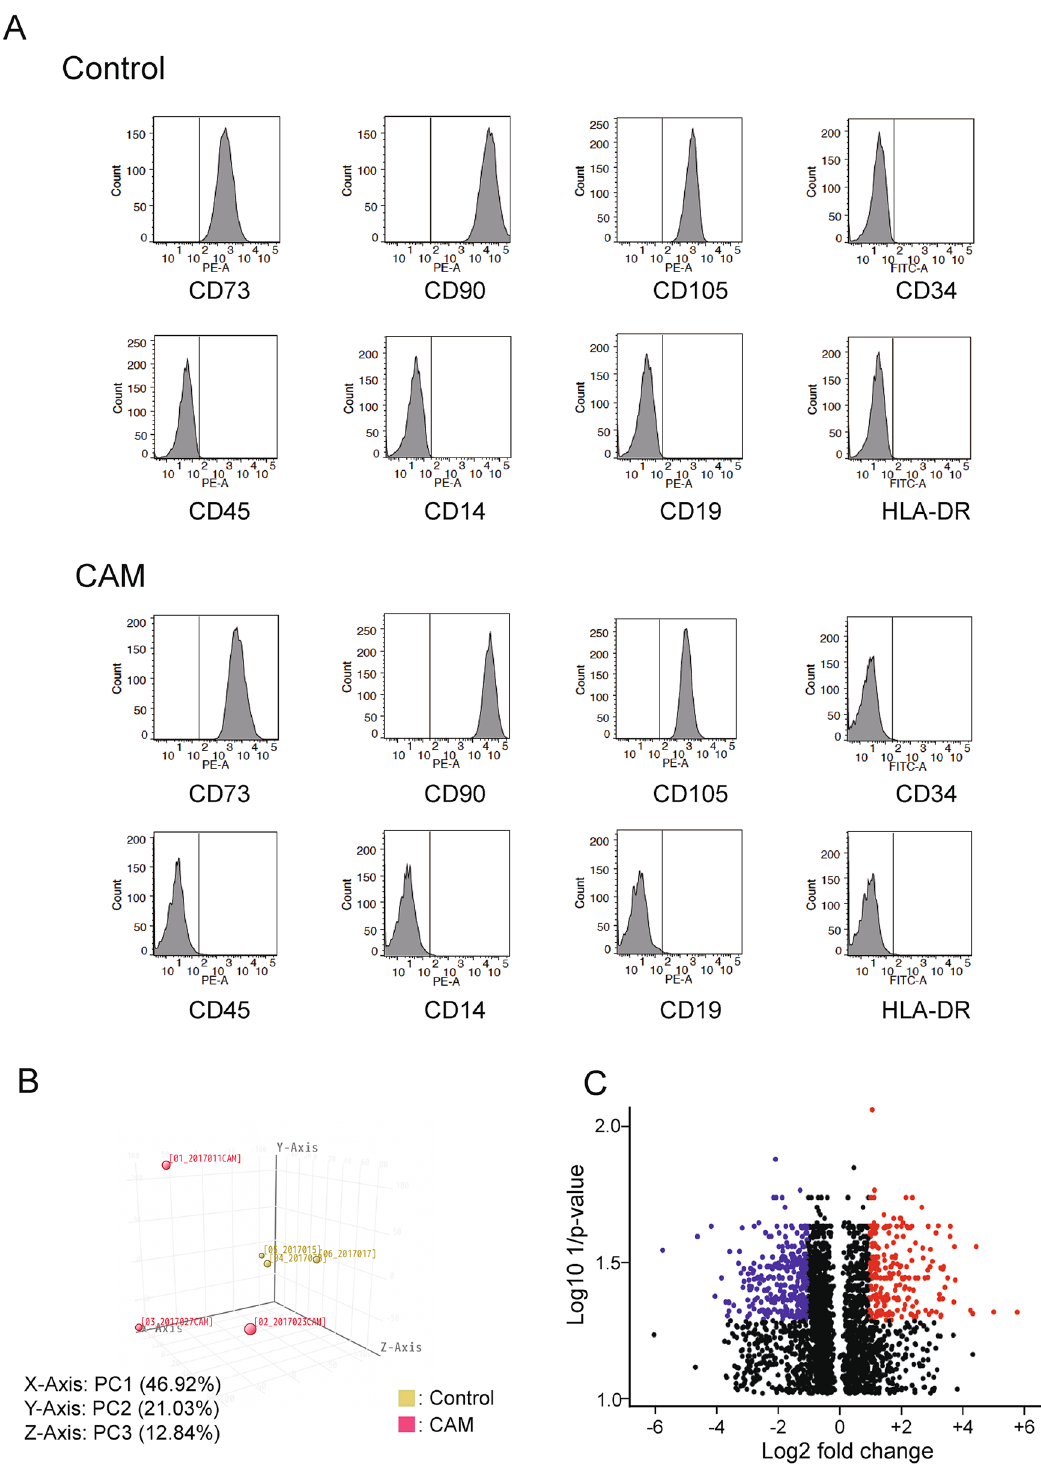
Figure 1. ( A ): Surface marker analysis by flow cytometry revealed that the cells obtained from umbilical cords had UCMSC features. The cells expressed CD73, CD90, and CD105, while not CD34, CD45, CD14, CD19, and HLA-DR; ( B ): Principal component analysis revealed that the gene expression profiles of the CAM group (red) were distinctively different from the normal healthy control, non-CAM group (yellow). ( C ): Volcano plot displaying the results of RNA-seq results from the CAM group and normal healthy controls. The genes that passed the thresholds for p value (Log10 1/ p value > 1.30) and log fold change (Log2 fold change > + 1 or < −1) were colored (red for upregulated and blue for